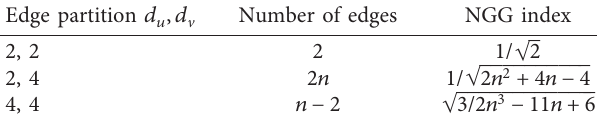
Table 4: Edge partition of oxide network of n